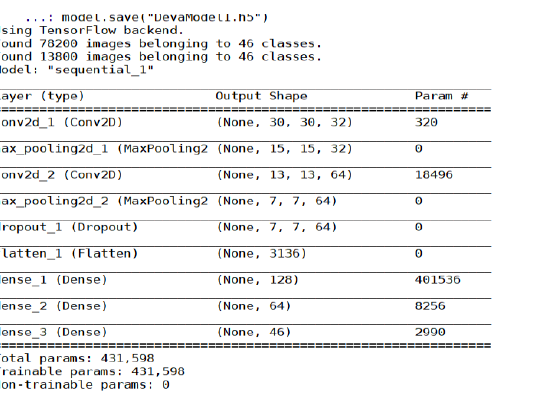
Fig. 8. CNN Architecture